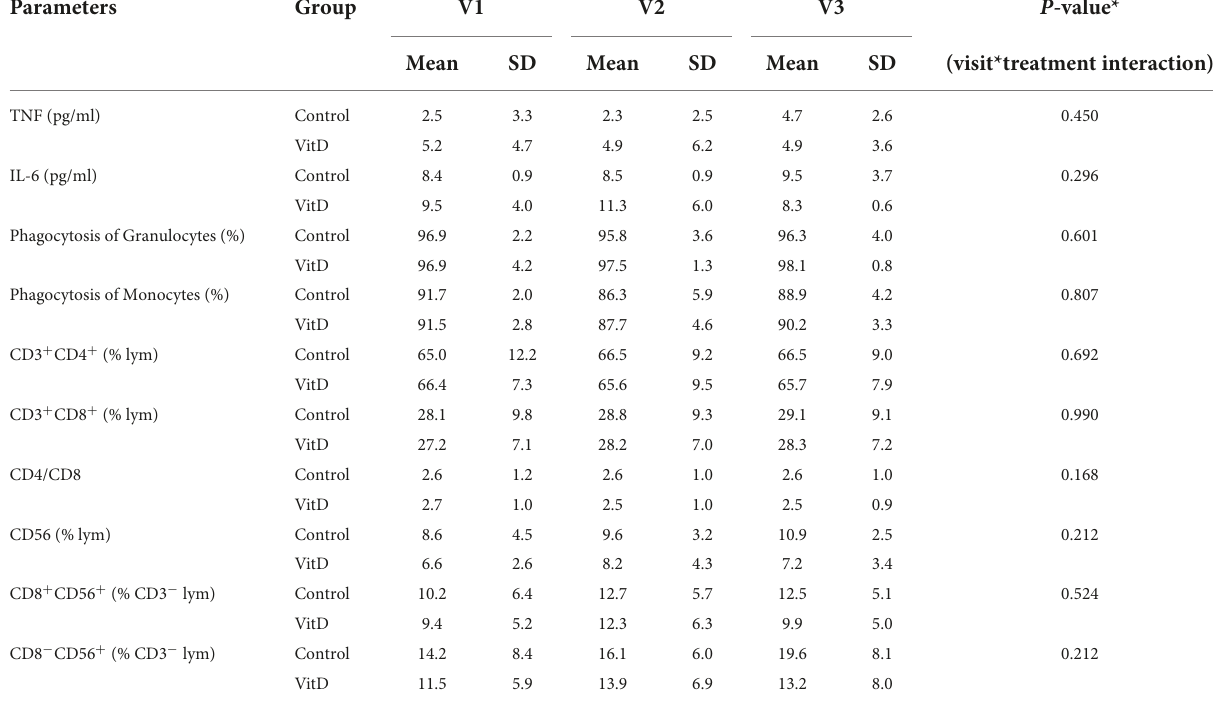
TABLE 7 Immunological parameters at different visits of the study.